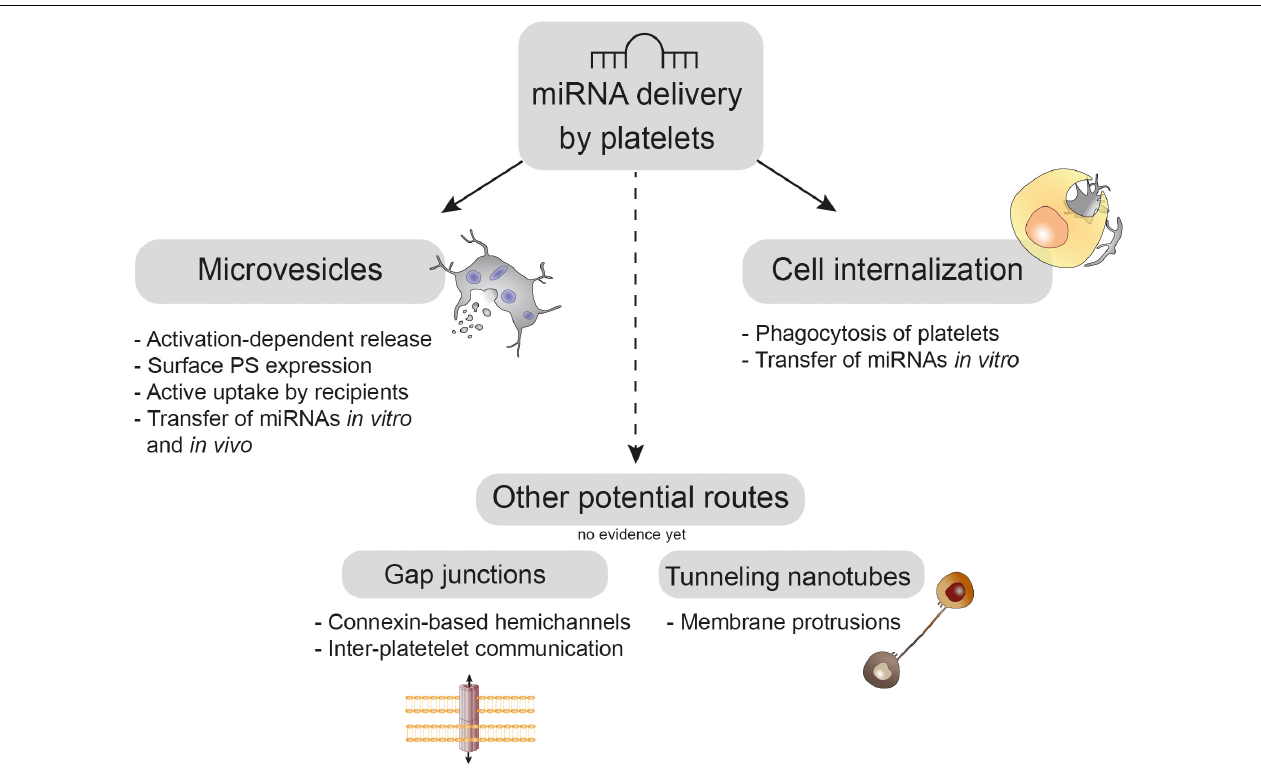
FIGURE 1 | Platelet-mediated delivery of miRNAs. Upon activation platelets shed phosphatidylserine (PS)-rich microvesicles from their budding cell membrane, which are actively taken up by recipient cells in vitro and in vivo . Moreover, platelets can be directly internalized by recipient cell phagocytosis, which was demonstrated in vitro . Whereas platelets use connexin-based gap junctions for inter-platelet communication, the role of these hemichannels in platelet miRNA transfer needs to be elucidated. Tunneling nanotubes are long membrane protrusions that enable exchange of nucleic acids between cells; however, their usage for platelet-mediated miRNA transfer has not been shown,